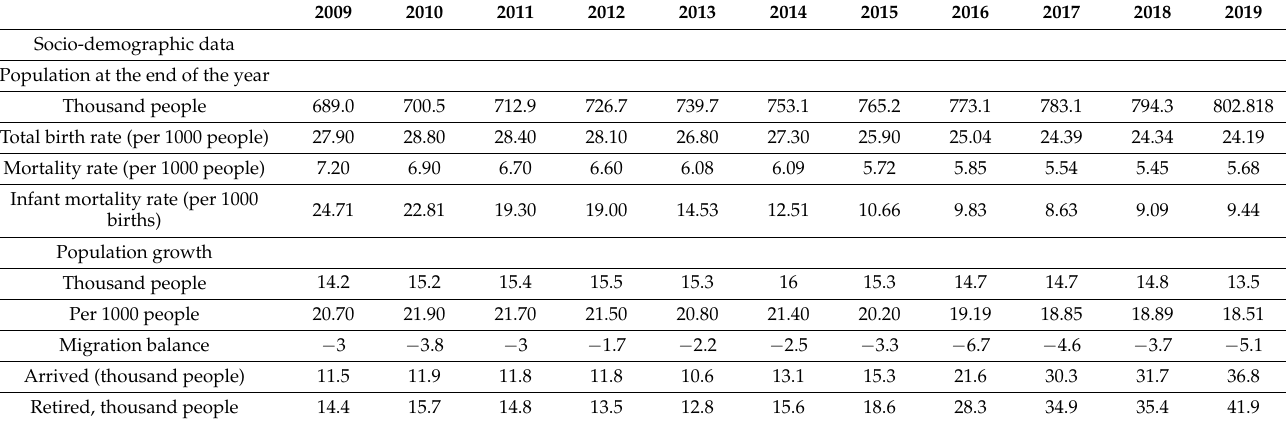
Table 2. Socio-demographic data in the Kyzylorda region.